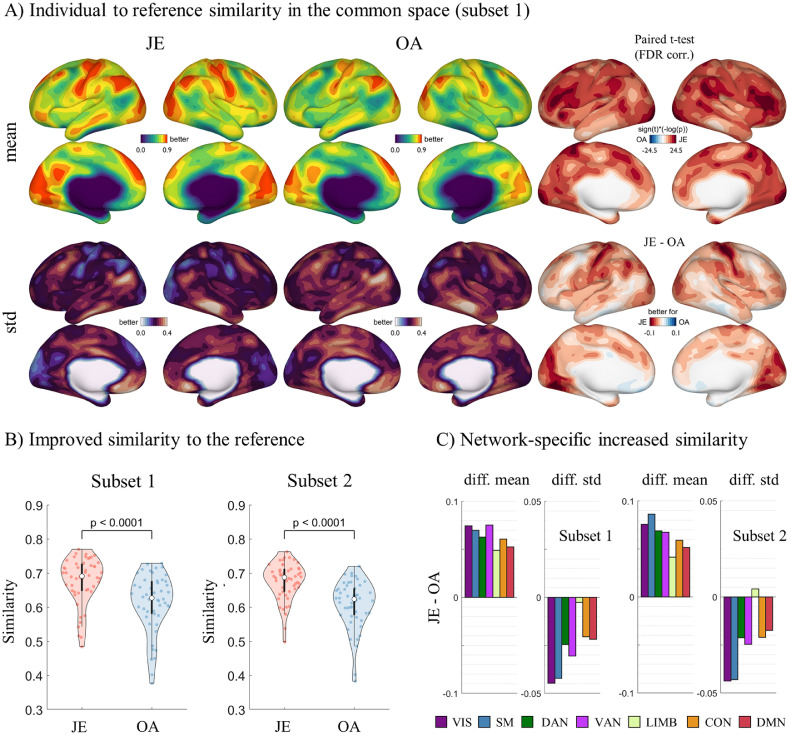
Average similarity of individual embedding component profiles to the reference. A) Notable cortical patterns of higher similarity and reduced variation are observed in JE compared to OA (see subset 2 results in Fig. S2). B) A paired t-test for individuals reveals a significant improvement of JE over OA for both subsets (subset1: t(49)=22.88, p < 0.0001; subset2: t(49)=24.54, p < 0.0001). C) Similarity of embedding component profiles to the reference at network level shows an increased similarity and reduced variance, particularly in somatosensory and visual networks.